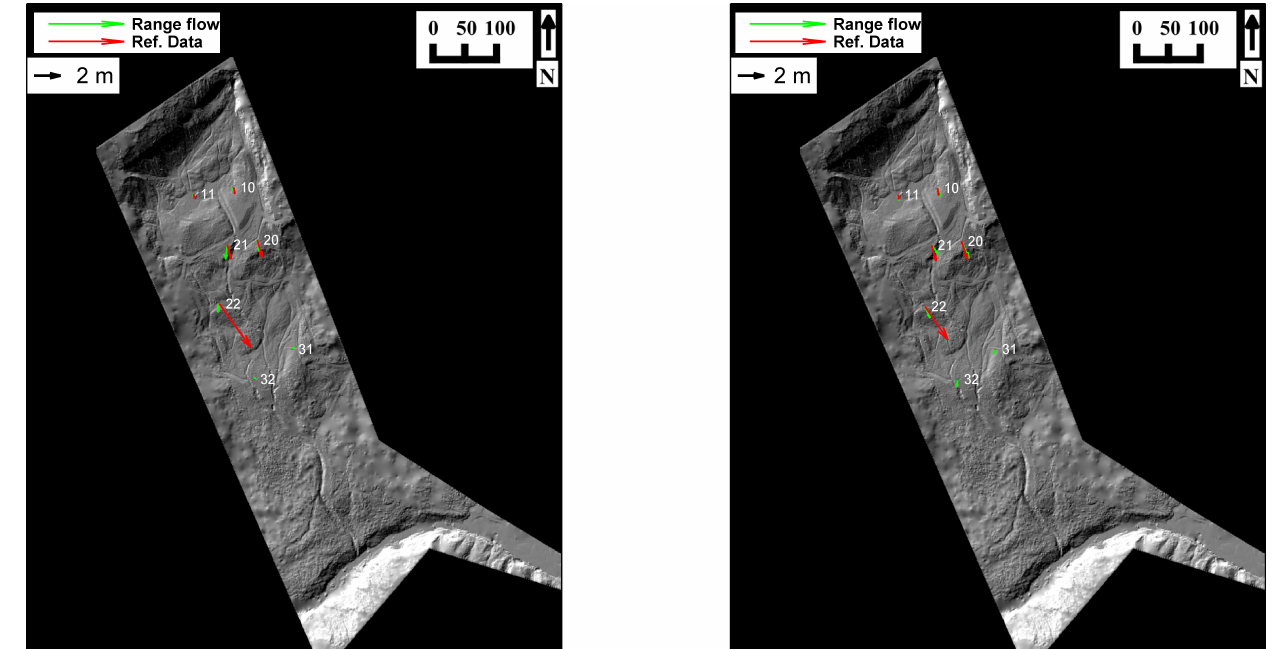
Figure 16. Motion vectors of the target points from reference data [52] and range flow overlaid over 2010